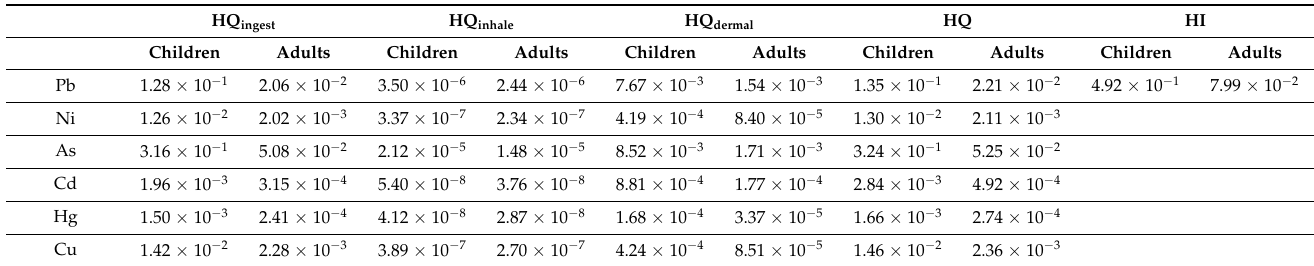
Table 4. The non-carcinogenic risk indexes of heavy metals in urban surface dust. HQ ingest HQ inhale